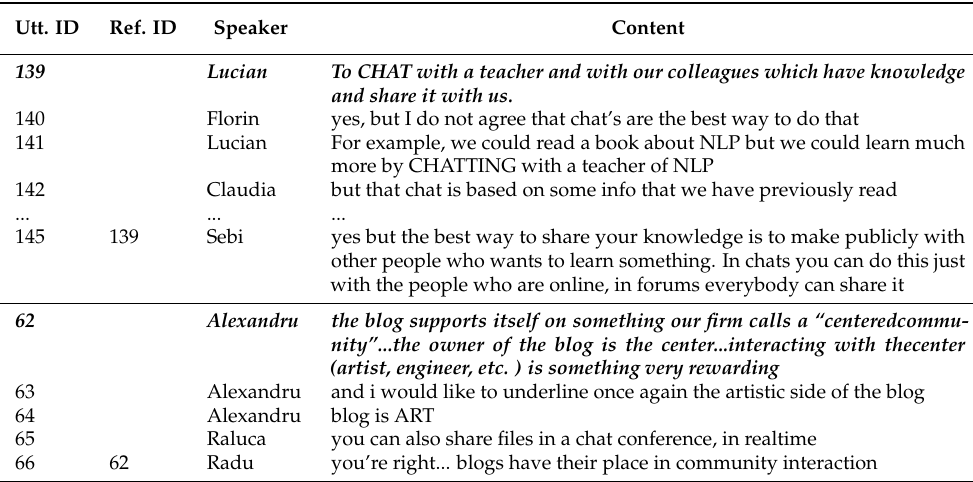
Table 7. Example of correct semantic link prediction ( explicit link / predicted link ).